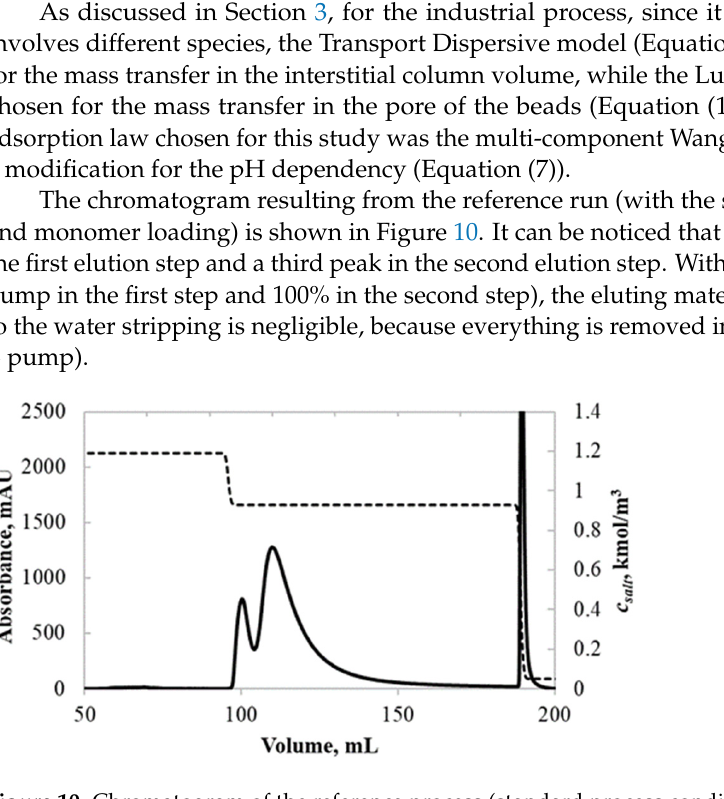
Figure 10. Chromatogram of the reference process (standard process conditions).